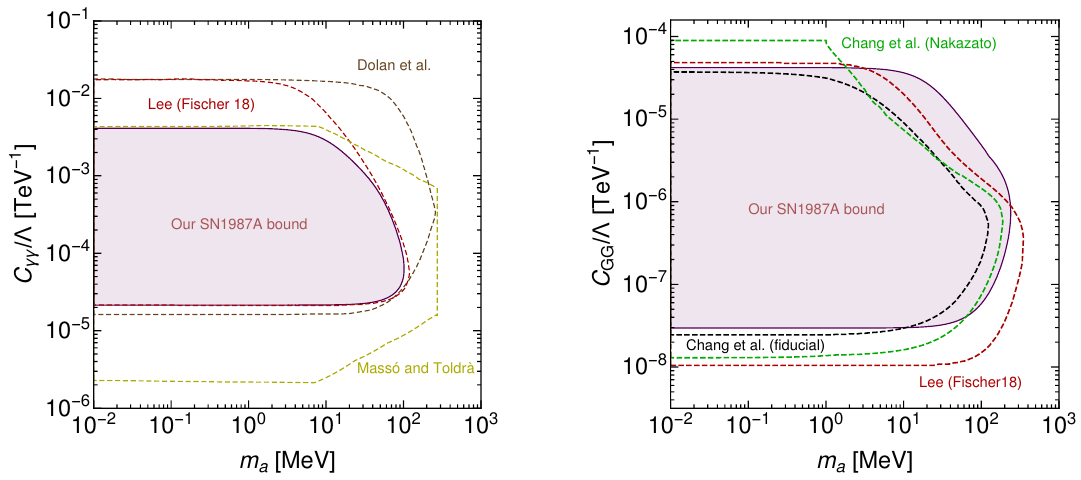
Figure 2 . Comparison of the di(cid:11)erent supernova bounds for a dominant ALP-photon coupling (left) and a dominant ALP-gluon interaction (right). We have taken the brown curve from ref. [52], the red curve from ref. [24], the yellow one from ref. [44] (originally computed in ref. [98]), the black as well as the green one from ref. [25] and the purple coloured area corresponds to our result for the (cid:12)ducial